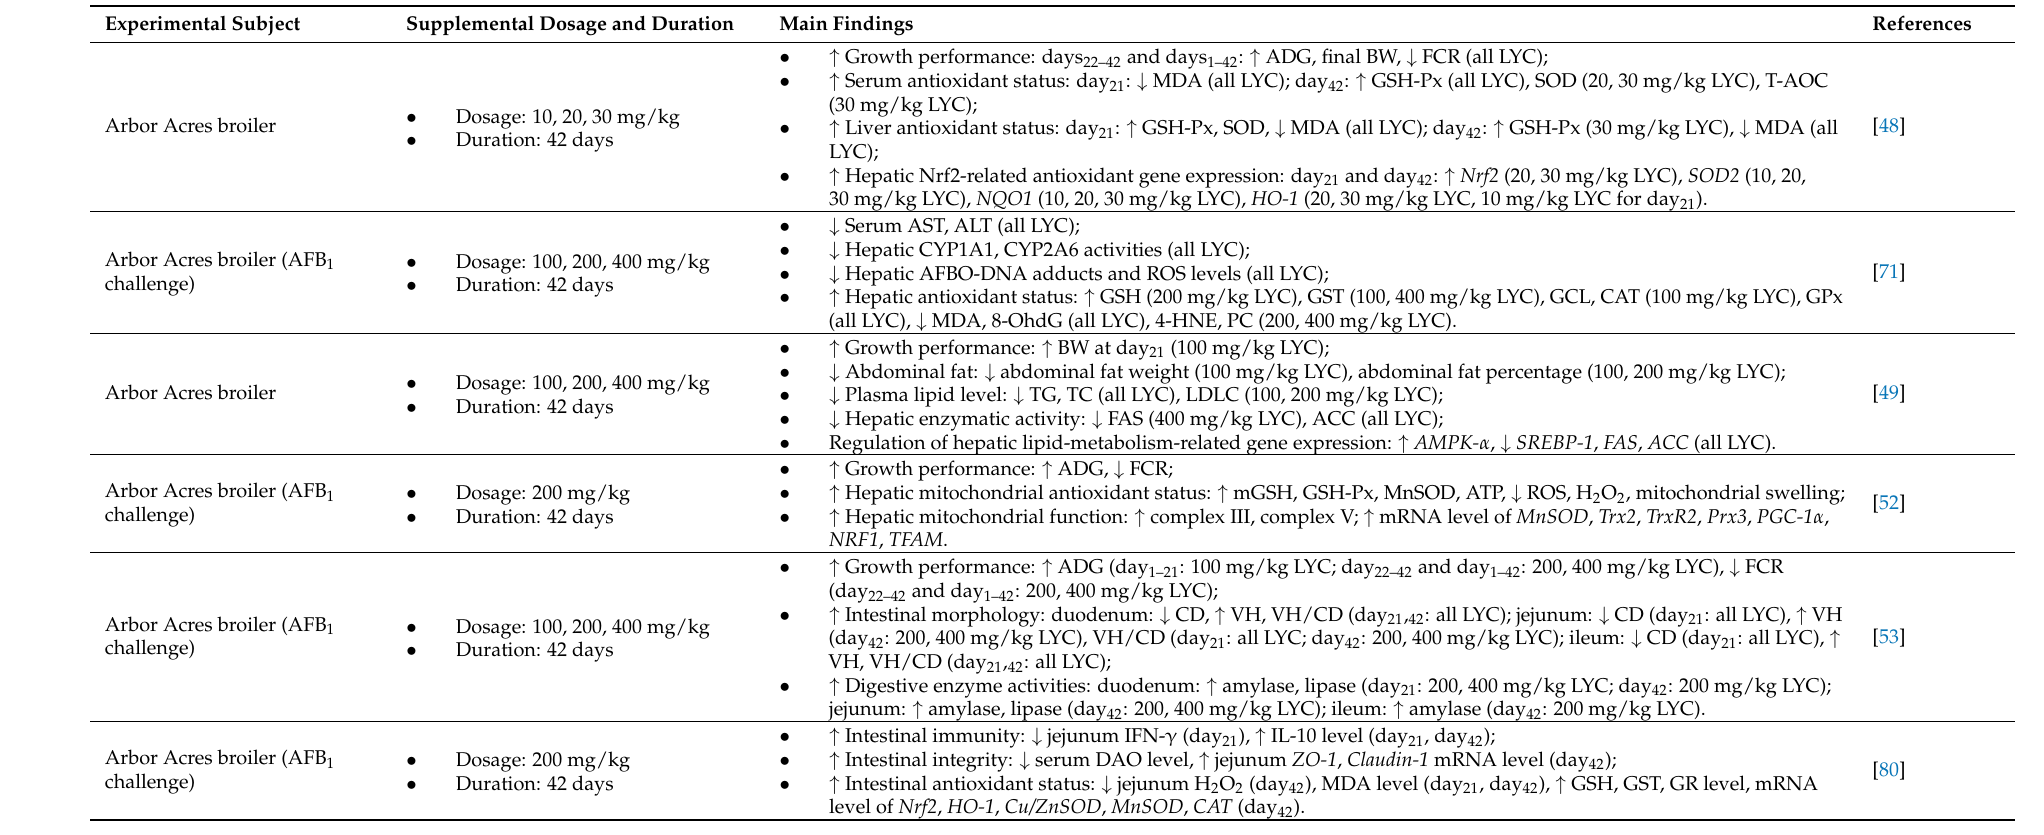
Table 2. The summary of lycopene (LYC) as a functional feed additive for meat-producing poultry during the past decade